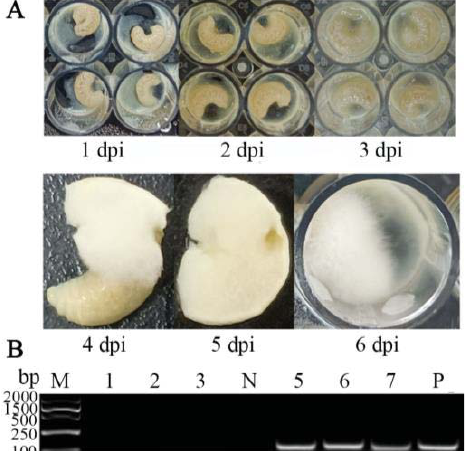
Figure 1. Observation and verification of A. apis infection of A. cerana larvae. ( A ) Observation of larval chalkbrood symptom after A. apis spore inoculation; ( B ) PCR validation of larval guts inoculated with A. apis spores. Lane M: DNA marker; Lane 1–3: uninoculated 6-, 5-, and 4-day-old larval guts; Lane N: sterile water (negative control); Lane 5–7: A. apis –inoculated 6-, 5-, and 4-day-old larval guts; Lane P: purified spores of A. apis (positive control).